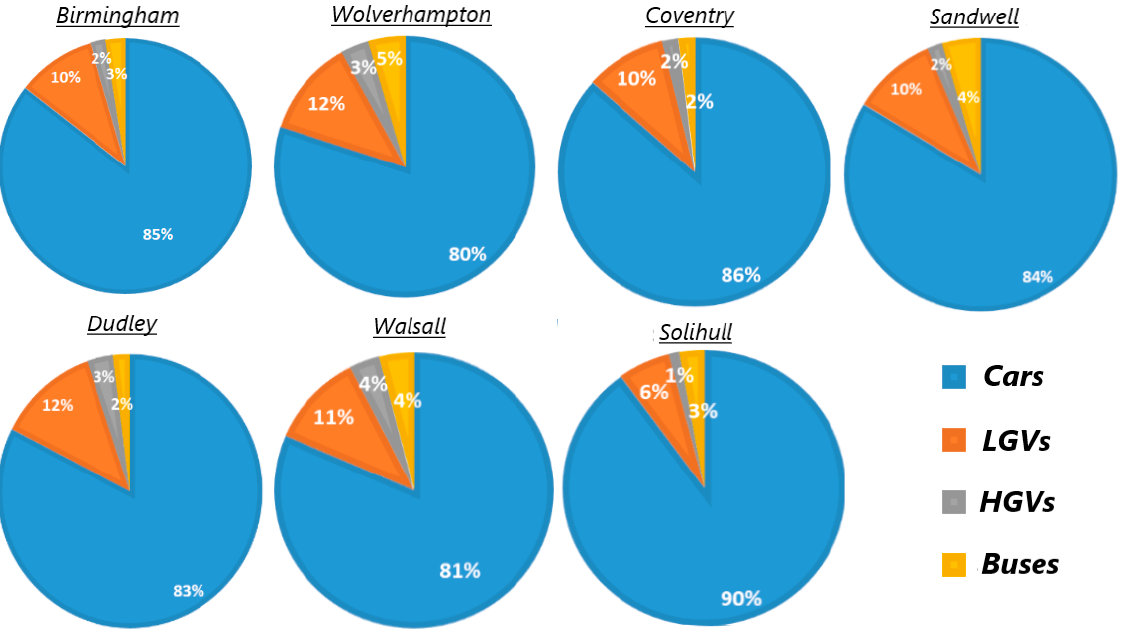
Figure 2. Traffic composition in the seven WM boroughs. These data were extracted from the Transport for West Midlands (TfWM).